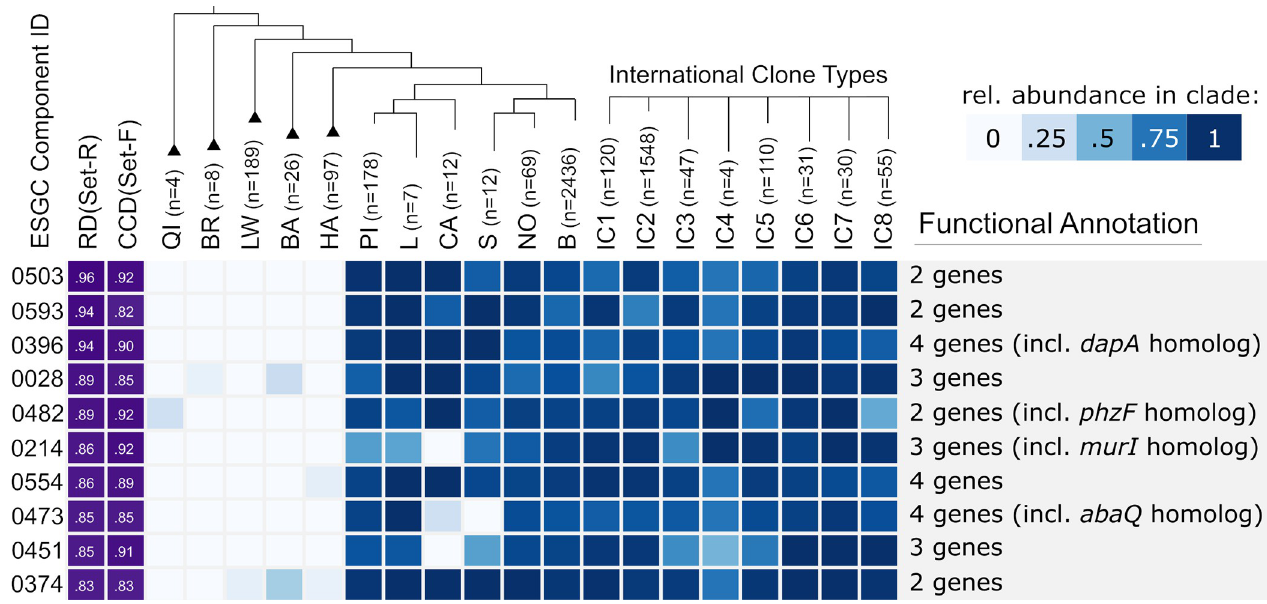
Fig 6. Top 10 ESGC ACB with unknown cluster function. The genes of these clusters are mostly annotated as ‘hypothetical” or “DUF-containing protein”, i.e. proteins with annotated with a domain of unknown function. Due to their stable microsynteny and high prevalence across the ACB clade, they are highly interesting candidates for further functional characterization. The figure layout follows Fig